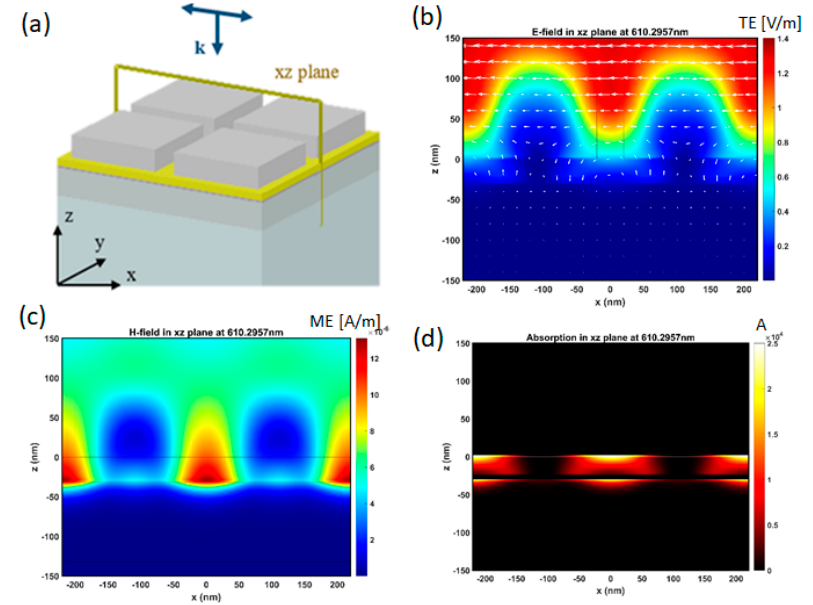
Figure 5. ( a ) Three-dimensional schematic view of the MPA along the x – z plane. Simulated ( b ) electric field, ( c ) magnetic field, and (d) absorption in the x – z plane for λ ≈ 610 nm.